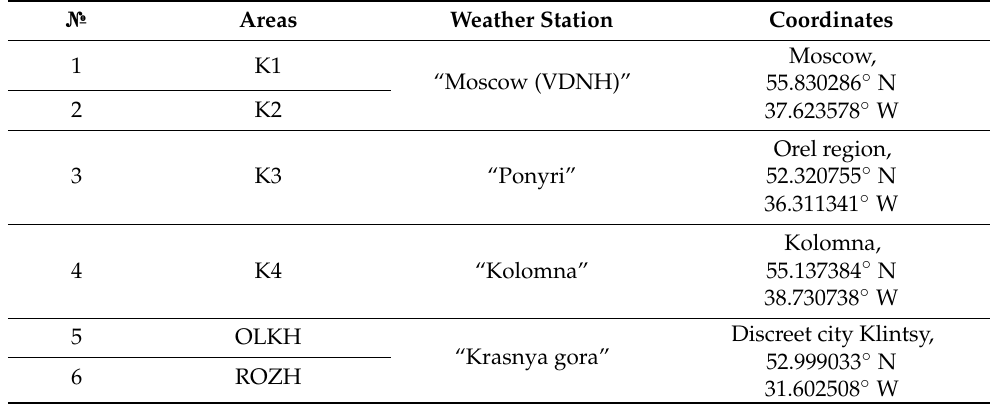
Table 2. Characteristics of weather stations. №